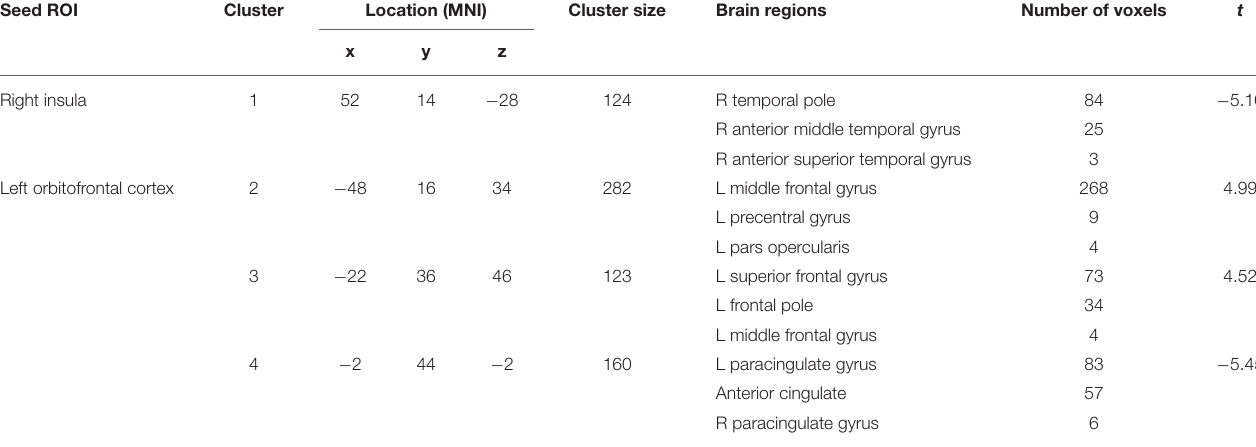
TABLE 1 | Results from seed-to-voxel analysis of apathy symptoms and functional connectivity of the right insula and left orbitofrontal cortex. Seed ROI Cluster Location (MNI) Cluster size Brain regions